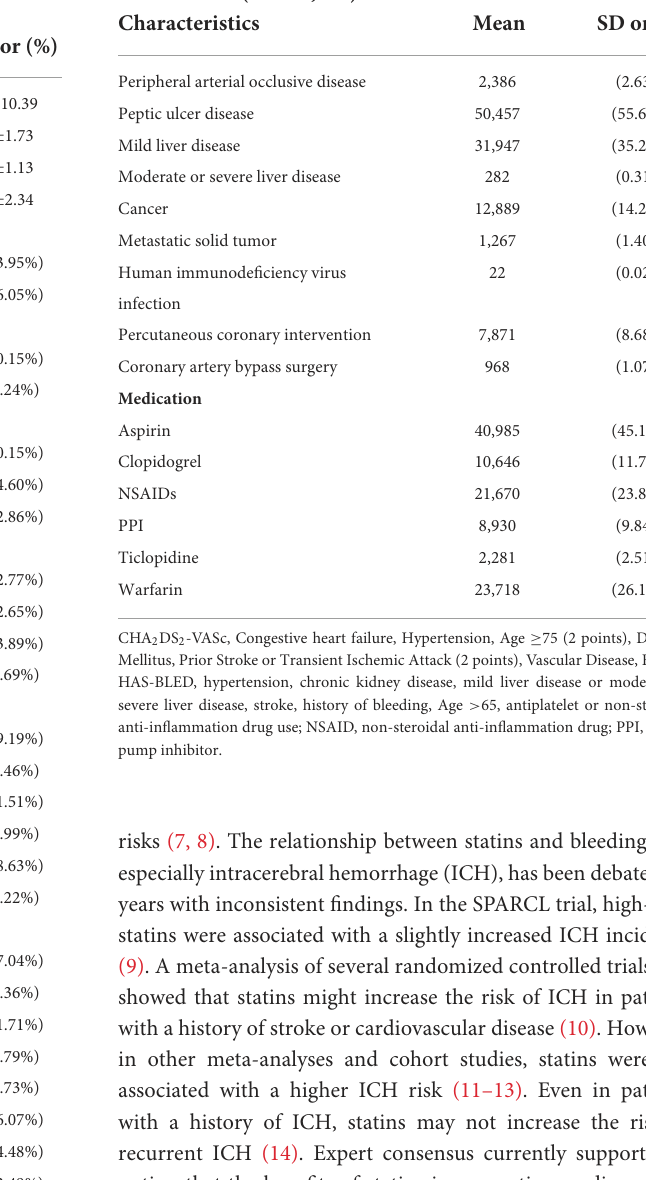
TABLE 1 Characteristics, comorbidities and medications among patients with non-valvular atrial fibrillation using DOACs. DOAC users ( n =